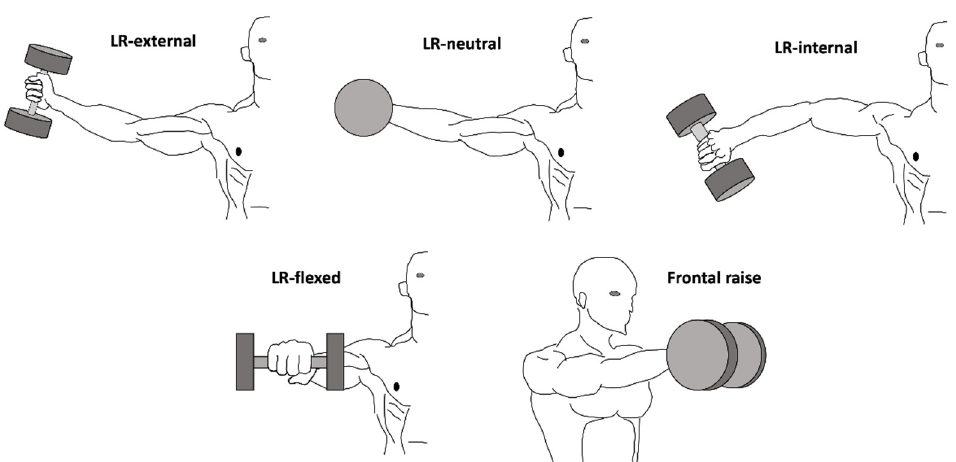
Figure 1. A schematic representation of the technique of each exercise is shown.